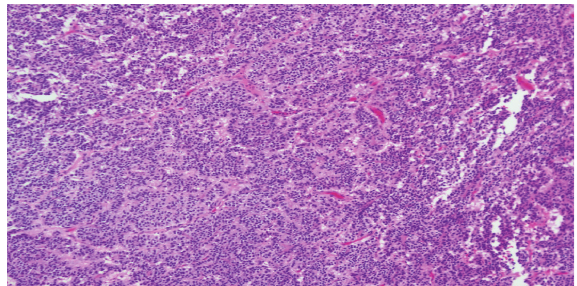
Figure 4: This histological section reveals a higher powered magnification of Figure 3 demonstrating the pituitary adenoma with elongated cells in a pseudorosette pattern.